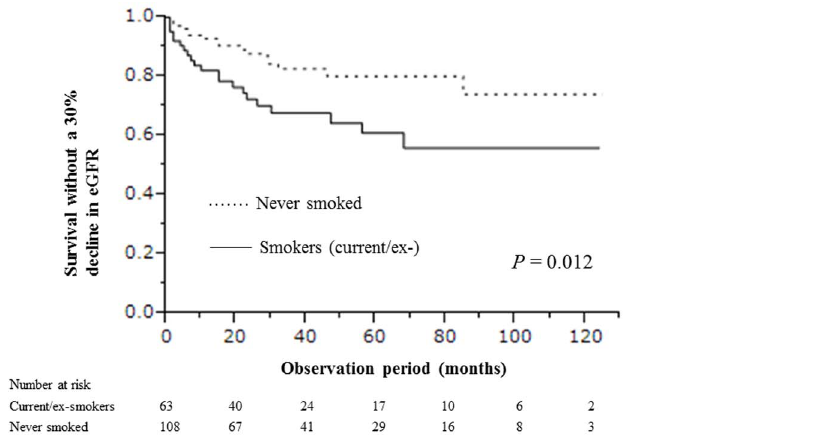
Figure 1. Time to 30% decline in eGFR in current/ex-smokers and those who never smoked.